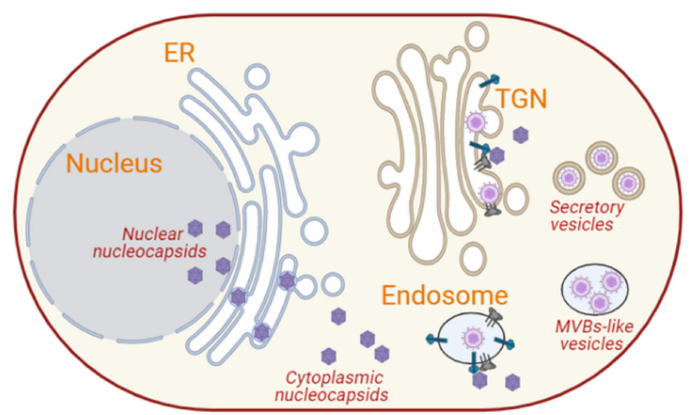
Figure 7. Intracellular membrane rearrangements induced by herpesviruses. Herpesviruses replicate and assemble their capsids in the nucleus, in which their glycoproteins are also targeted. They transiently acquire a primary envelope when crossing the inner nuclear membrane and lose it when exiting from the outer nuclear membrane. This passage also involves the disassembly of the nuclear lamina. Capsid and glycoproteins are transported from the ER to the TGN, where they interact with the cytoplasmic capsids to form intraluminal virions by inward budding. These viral particles are then transported to the plasma membrane and released extracellularly. Some herpesviruses, such as HHV-6, assemble their viral particles at the endosomes, generating MVB-like compartments that fuse with the plasma membrane to release the luminal virions (image created in